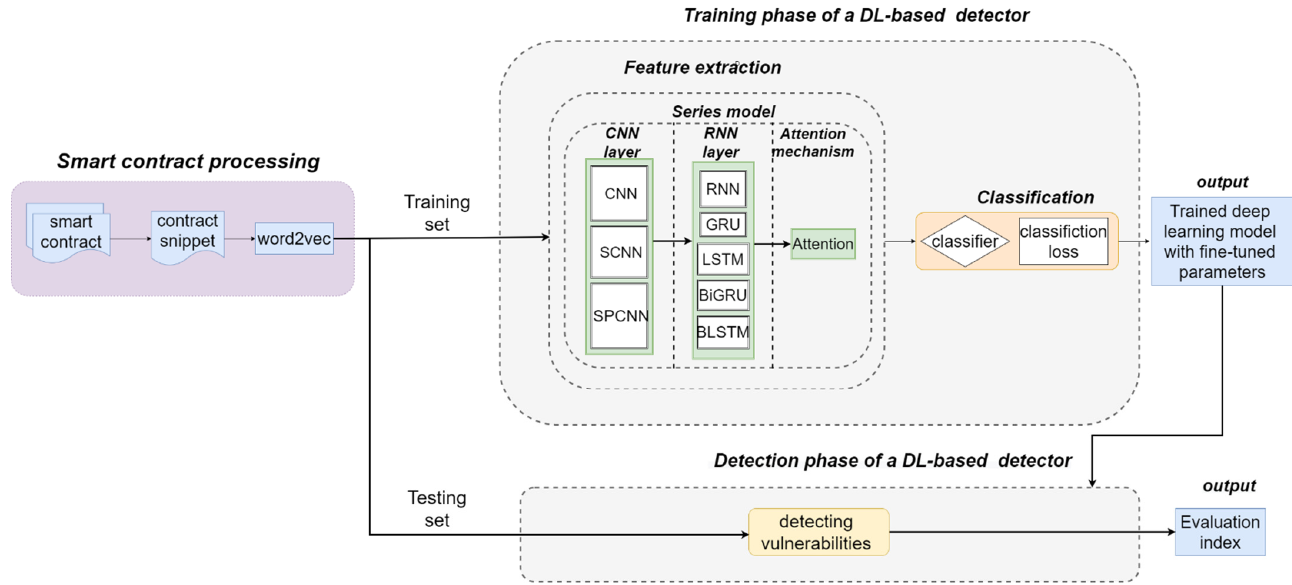
Figure 7. The SCR Detection Framework.